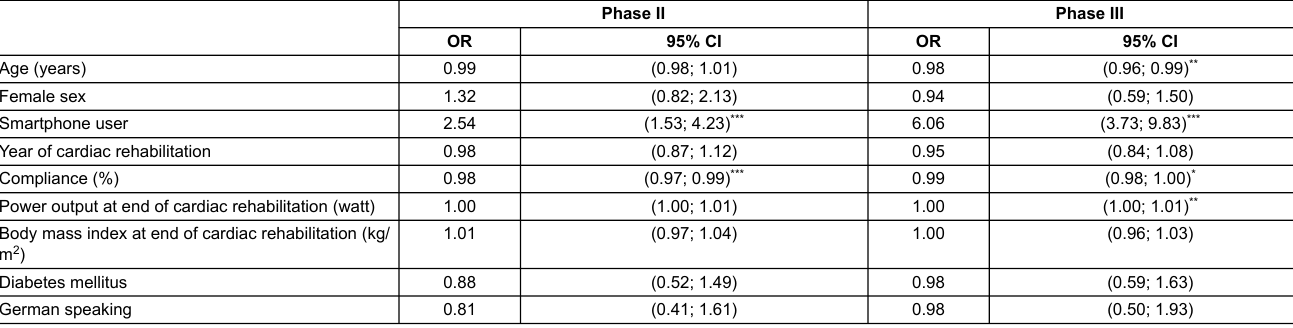
Table 3: Multivariate logistic models for smartphone application interest in phase II and phase III